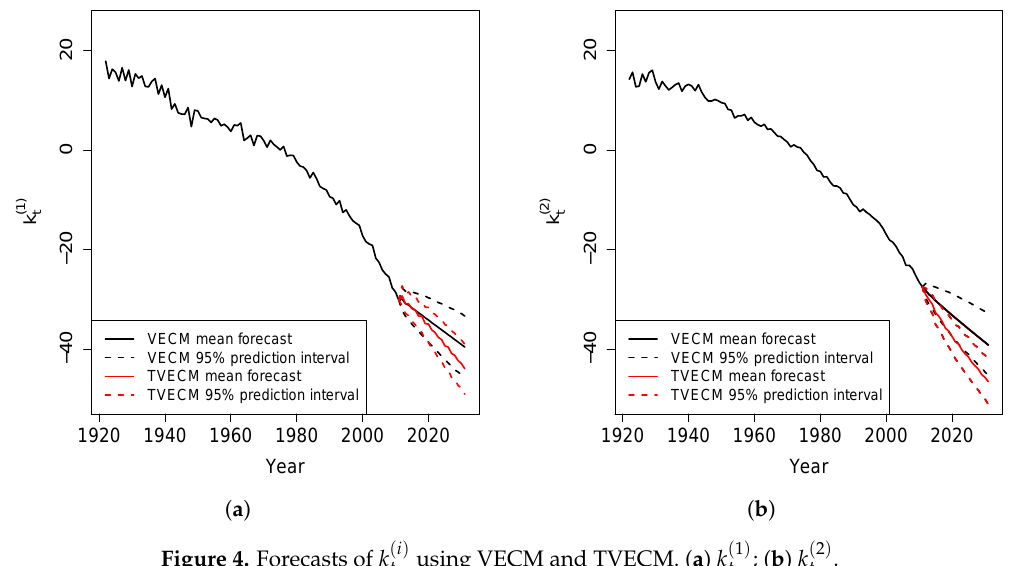
Figure 4. Forecasts of k